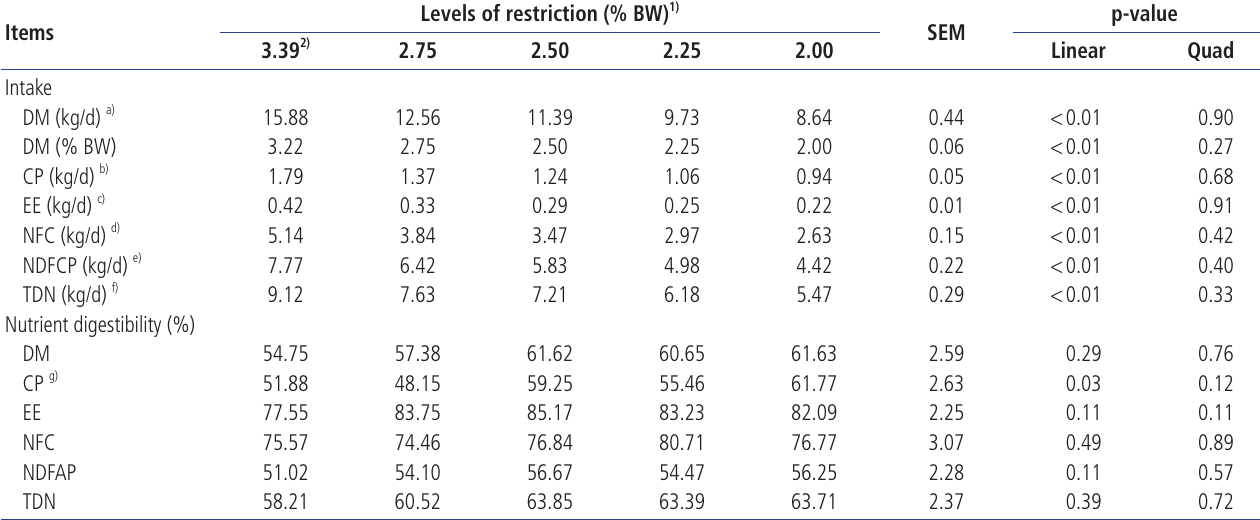
Table 2. Nutrient intake and digestibility in F1 Holstein/Zebu cows under quantitative feed restriction in the middle third of lactation